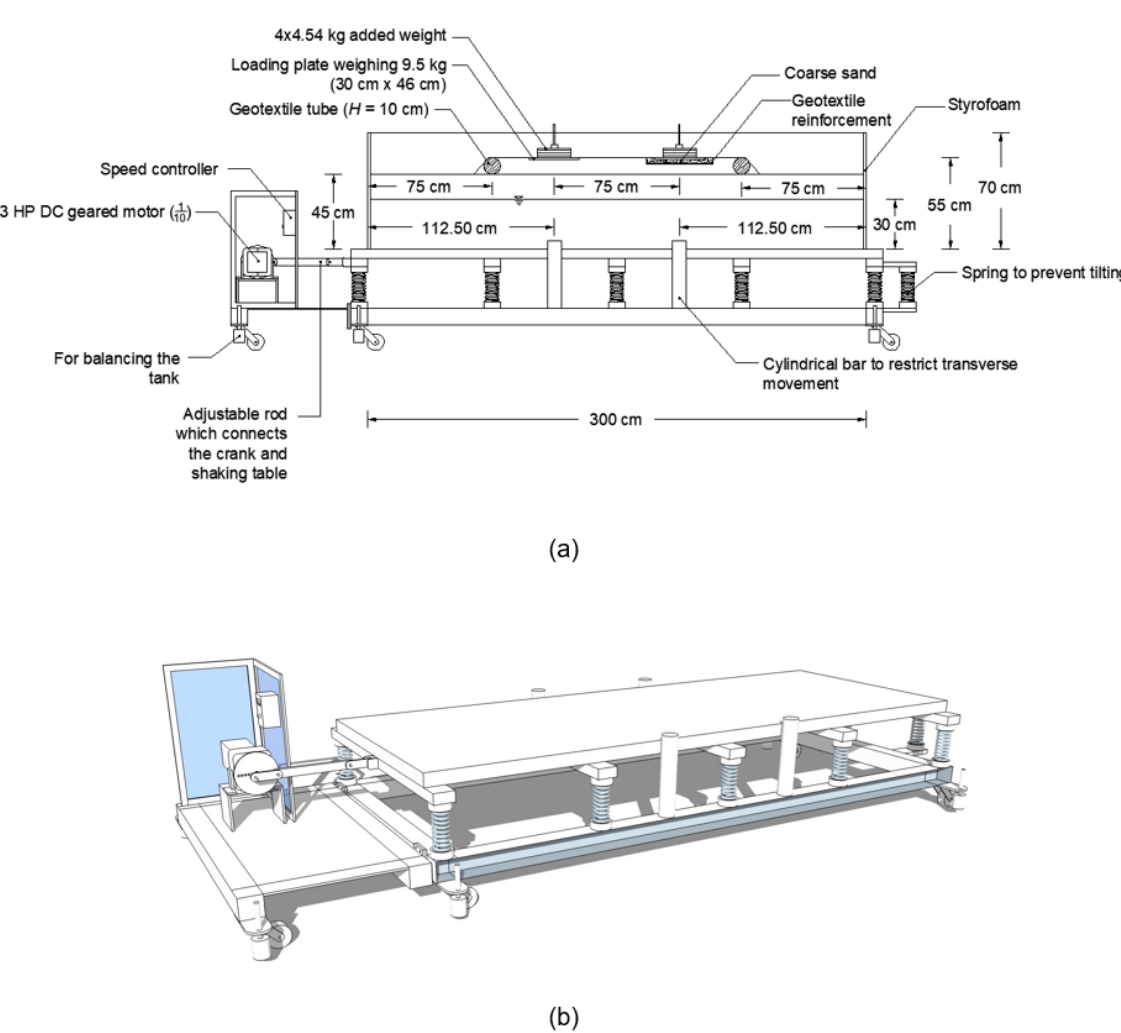
Figure 11. Shaking table test: ( a ) scale model test setup, and ( b ) isometric view of shaking table.